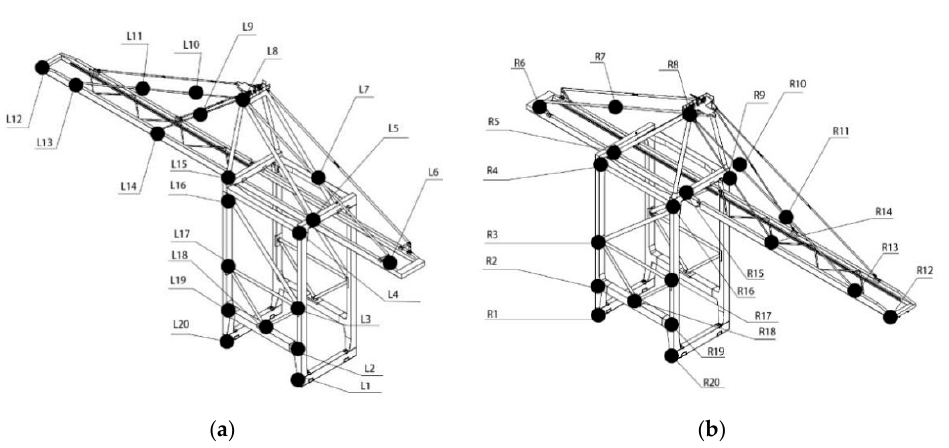
Figure 1. Vulnerable points of a quay crane: ( a ) left vulnerable points; ( b ) right vulnerable points. Table 1. Vulnerable points of a quay crane.